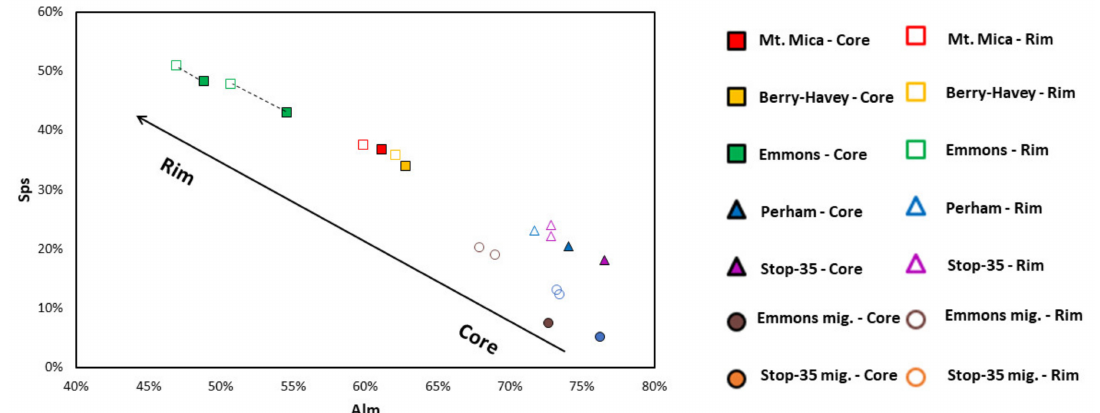
Figure 11. Plot of the almandine vs. spessartine proportions (mol %) in the analyzed garnets distinguishing the values in the core from those of the rims of the